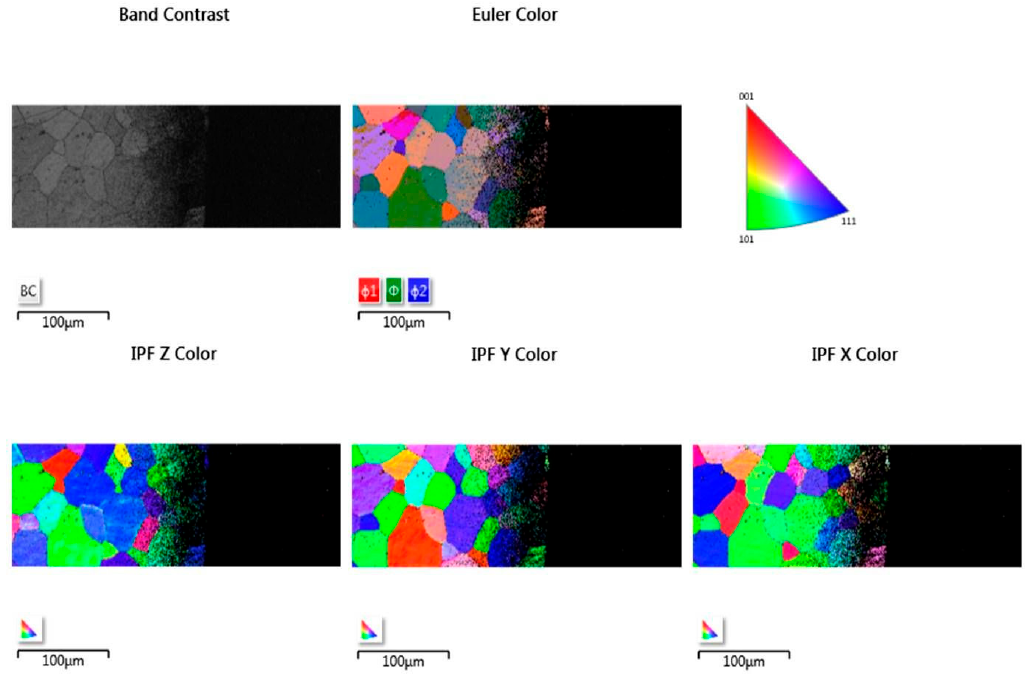
Figure 9. EBSD images of sputtered area of steel 1.4521 (AISI 444) at the sputtered and non-sputtered interface.